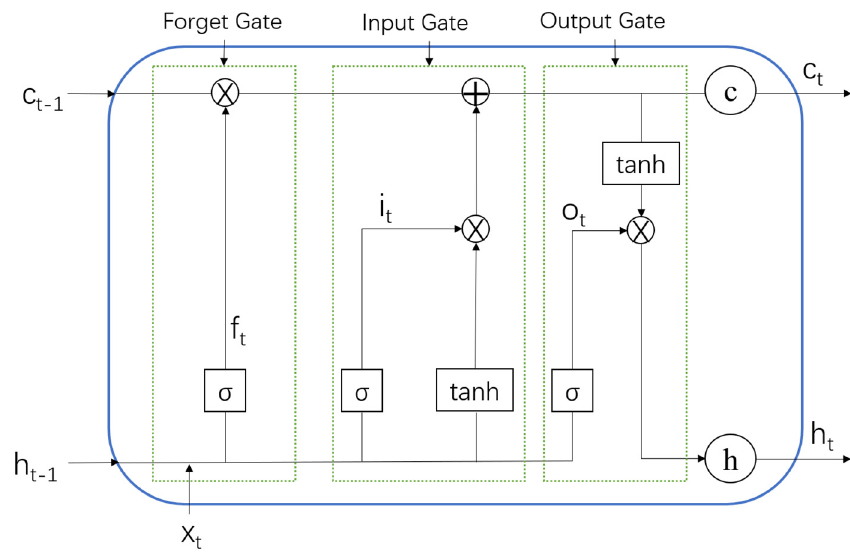
Figure 1. The LSTM model structure.